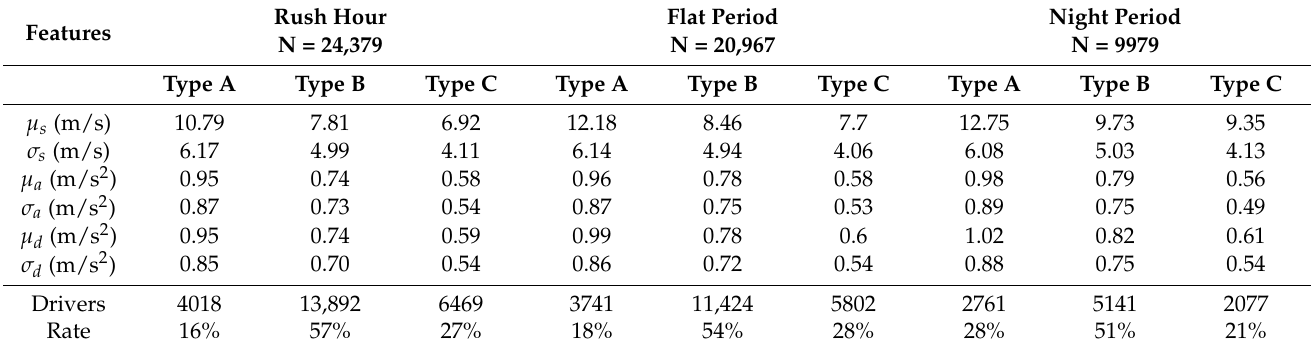
Table 6. Clustering results of driving styles for different time periods (cluster